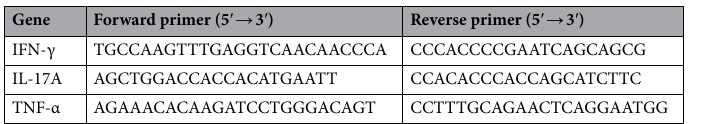
Table 2. Sequences of primers used for RT